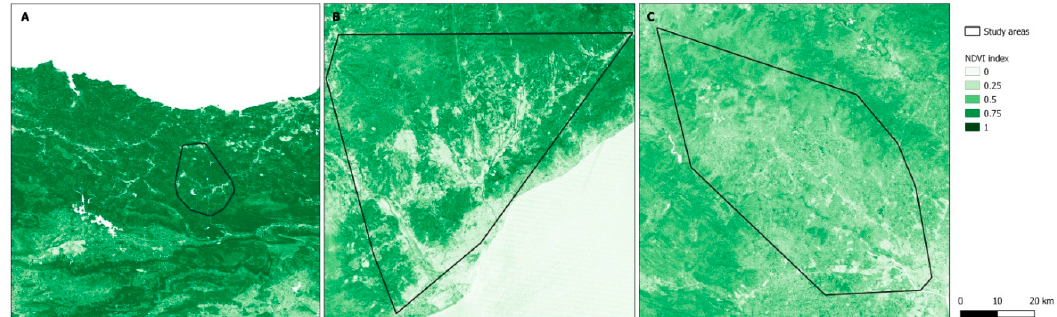
Figure 2. Landsat NDVI imagery and study areas. ( A ) Guipuzkoa (June 2010), ( B ) Valencia (May 2010), ( C ) Sabadell (May 2007).